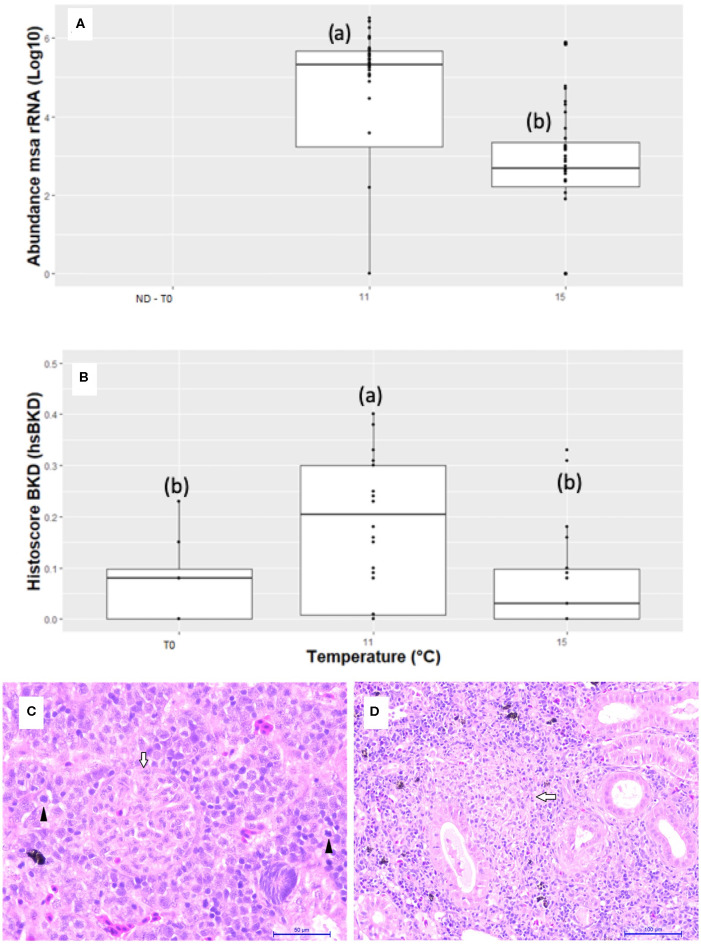
Abundance of msa transcripts of R. salmoninarum and BKD histoscore in the head kidneys of Atlantic salmon pre-smolts infected at 11 and 15°C. (A) The abundance of msa transcripts of R. salmoninarum in infected fish at 11 and 15°C and non-infected fish. The relative quantification of the msa gene in kidneys is expressed as the log10 value of the number of copies of the msa gene of R. salmoninarum in the infected fish group compared to that in the non-infected control group (ND, not detected). (B) Histopathological lesions expressed as a BKD histoscore in infected fish at 11 and 15°C and non-infected fish. (C) Hyperplasia with mitotic figures (black arrows) in hematopoietic tissue, renal corpuscle with mesangial cell hyperplasia (white arrow) and capillary obliteration (HandE, 40X bar 50 μm). (D) Mixed granuloma in the initial stage of formation (white arrow) in kidney of Atlantic salmon pre-smolts infected with R. salmoninarum (HandE, 20X bar 100 μm).